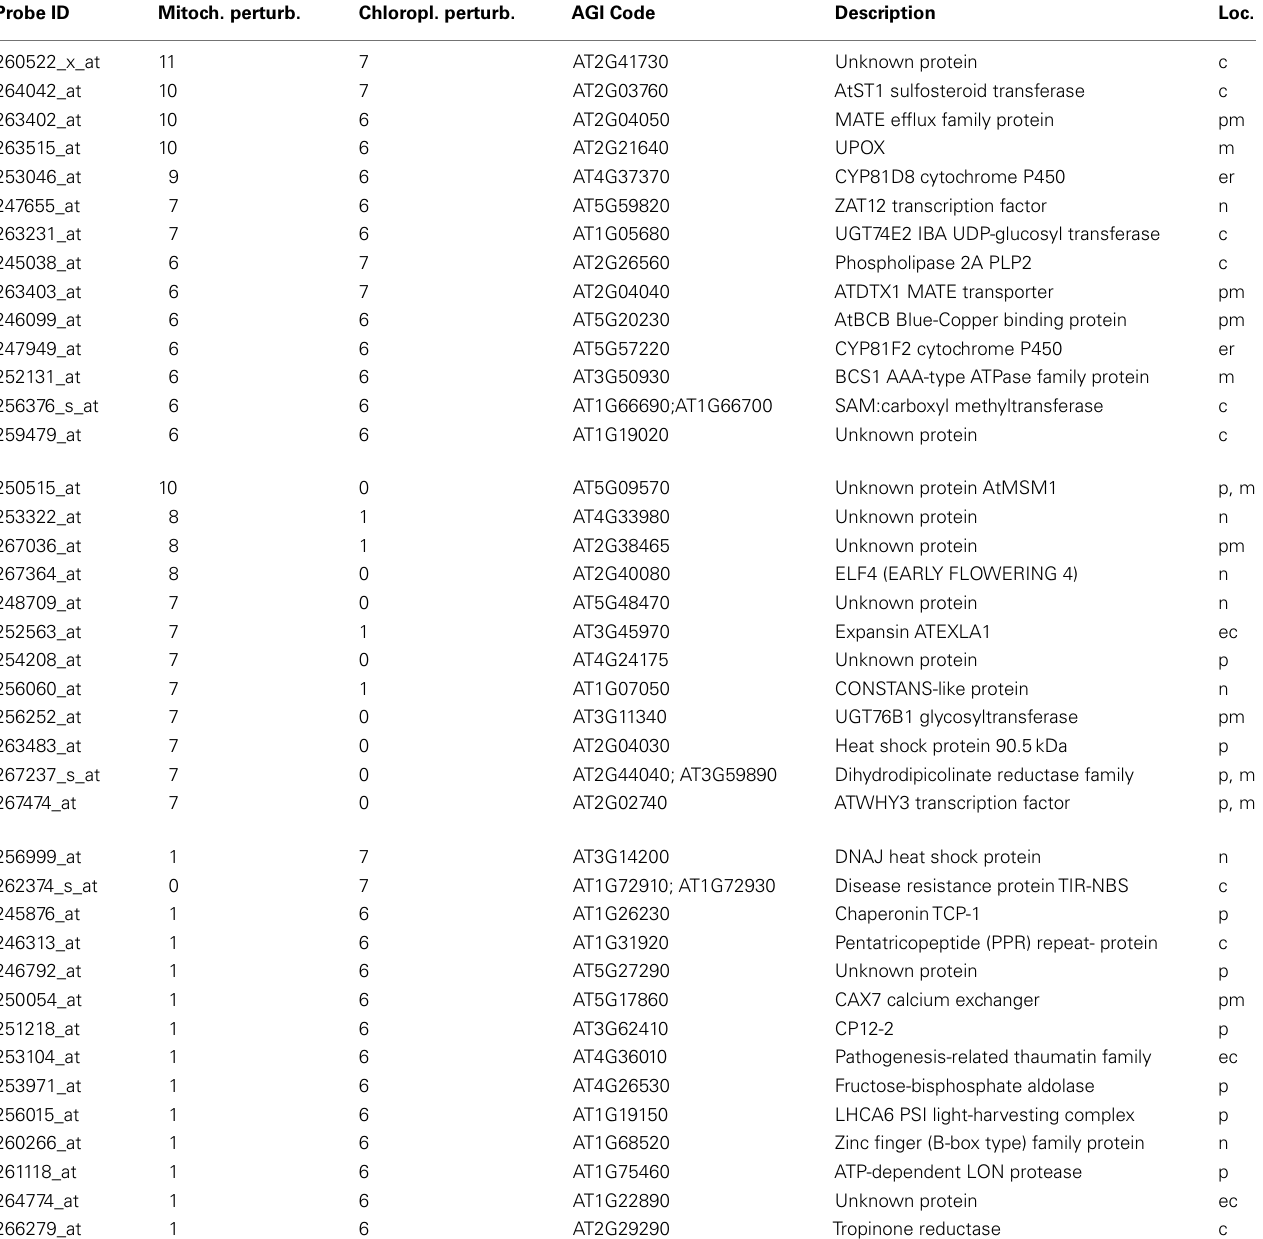
Table 4 | Marker genes for mitochondrial and/or chloroplast